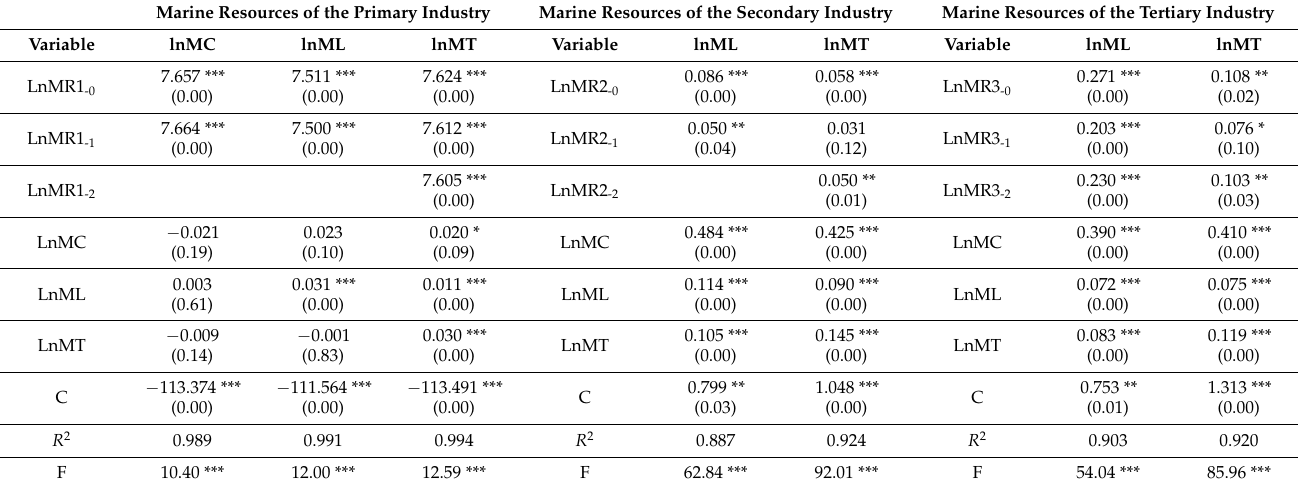
Table 6. Regression results of thresholds for marine resources and economic